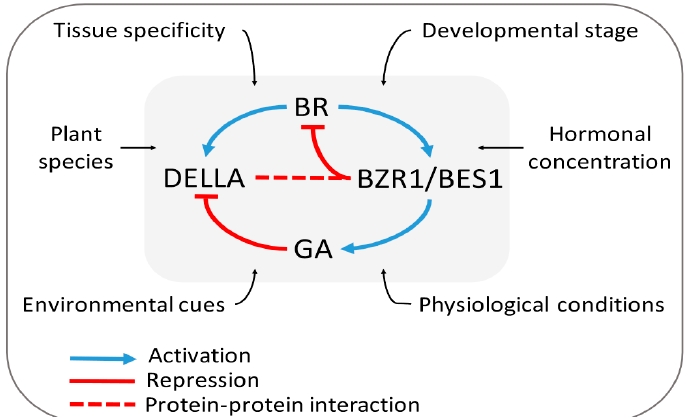
Figure 4. The integrated model for BR–Gibberellin (GA) cross-talk. BR activates BRASSINAZOLE RESISTANT 1/BRI1-EMS SUPPRESSOR 1 (BZR1/BES1) to promote GA biosynthesis and production. As a consequence, GAs degrade DELLA proteins, releasing their repressive action on BZR1/BES1 activity. Some critical factors, emphasized above, may influence and alter this interaction over time and should be considered when discussing BR–GA coordination in plants (e.g.; BR-induced accumulation of DELLA at dawn in the early stages of Arabidopsis development).